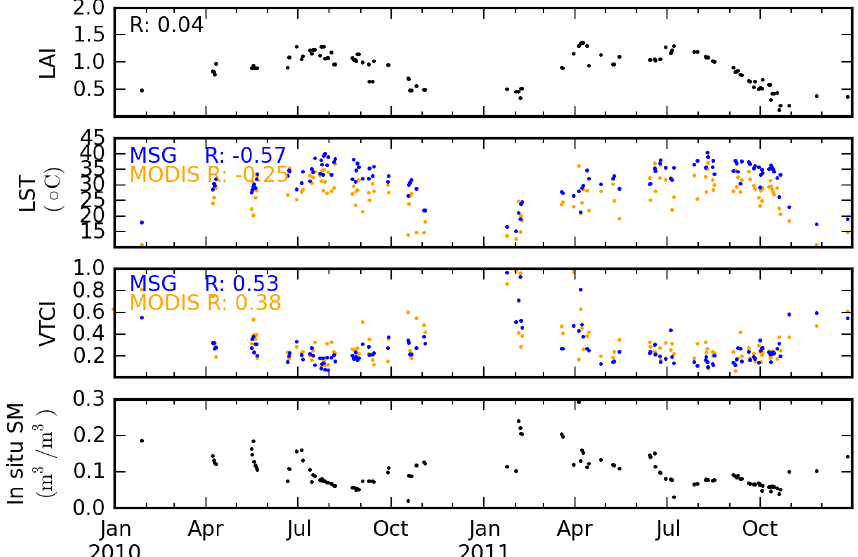
Figure 4. Time series of the station-averaged LAI, surface temperature, VTCI, and in situ soil moisture over REMEDHUS during the study period. The R values listed in the figure refer to the correlation coefficient with measured soil